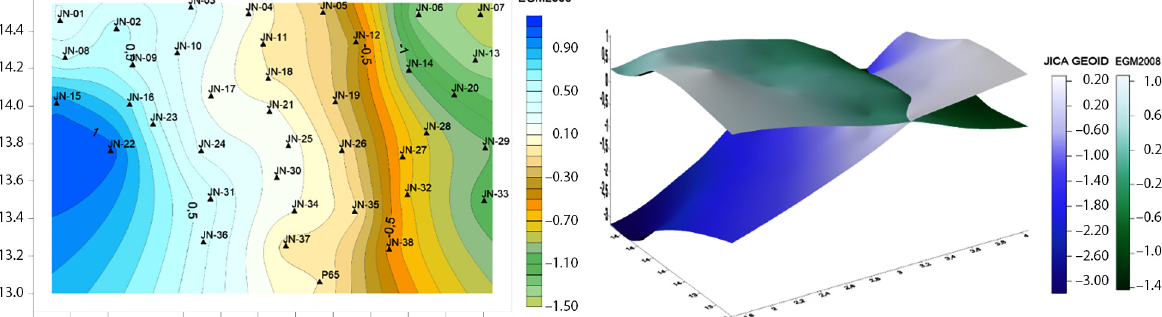
Fig. 9. Relative geoids’ variations